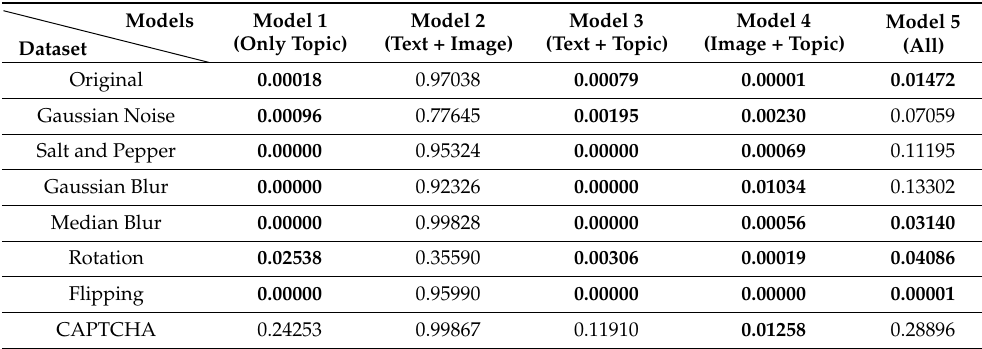
Table 14. p -values of the chi-square test with Baseline-2 on the ISH dataset.